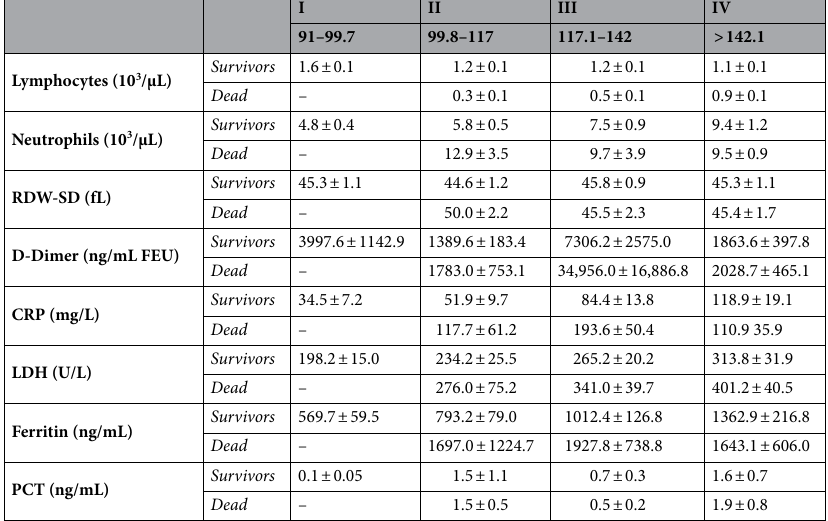
Table 2. Hematochemical parameters in survived and deceased COVID-19 patients in relation to sFLT-1 quartiles